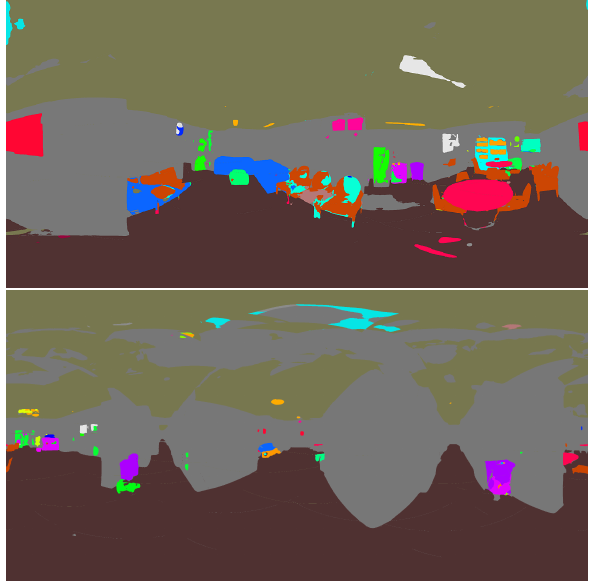
Figure 6. Final semantic segmentation results for our internal dataset ( top ) and 2D3DS dataset ( bottom